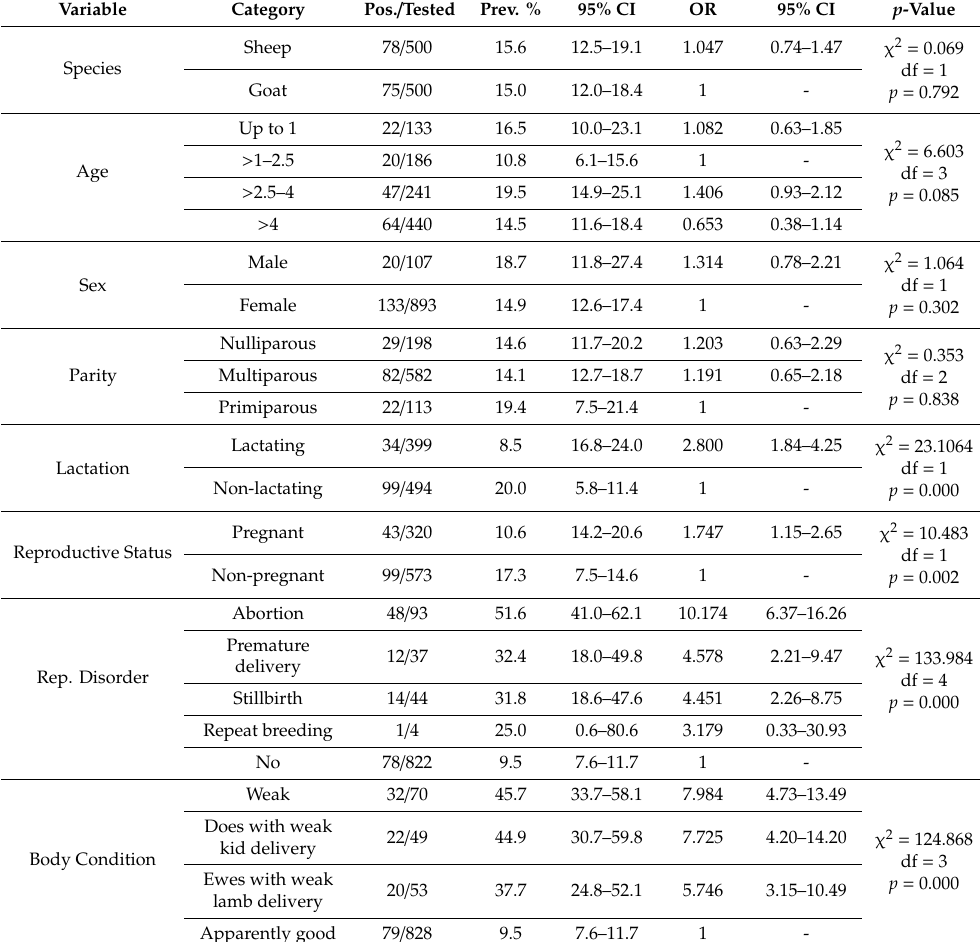
Table 2. Analysis for the serological results of coxiellosis in small ruminants in seven farms in the Punjab, Pakistan, in relation to potential risk